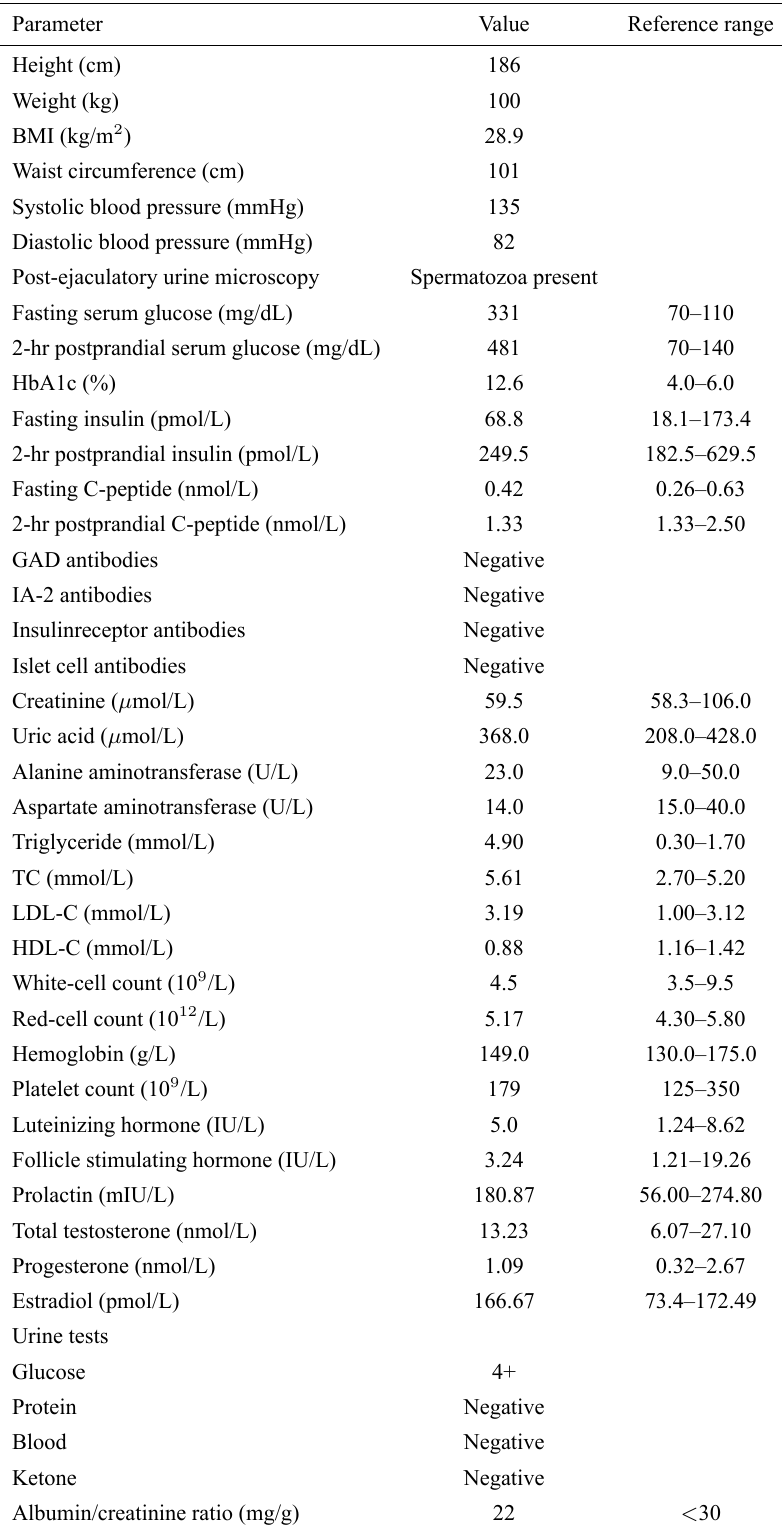
Table 1. Physical examination and clinical laboratory results at